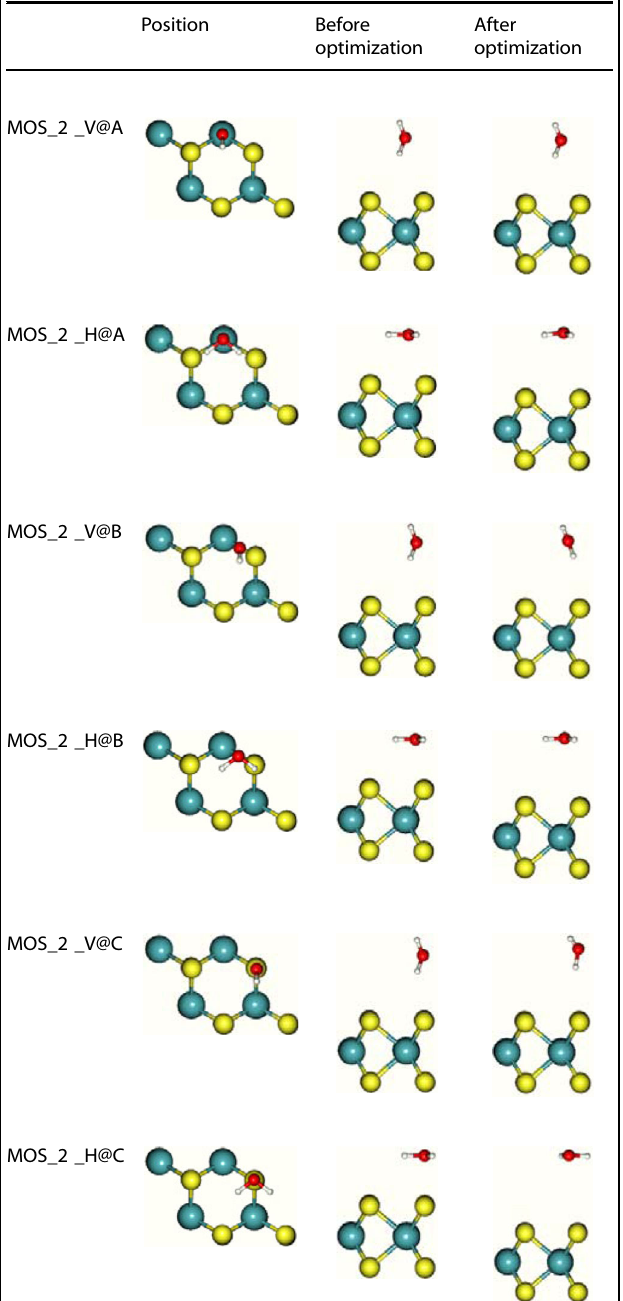
Table 3. Fully relaxed distances for water vapor (H 2 O) on top of MoS 2 monolayer in different positions.